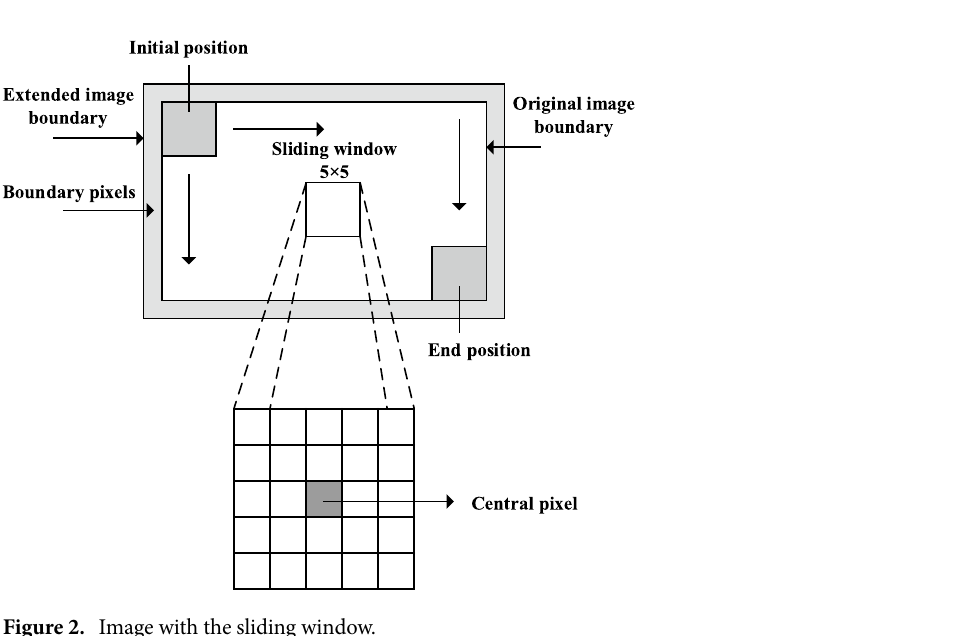
Figure 2. Image with the sliding